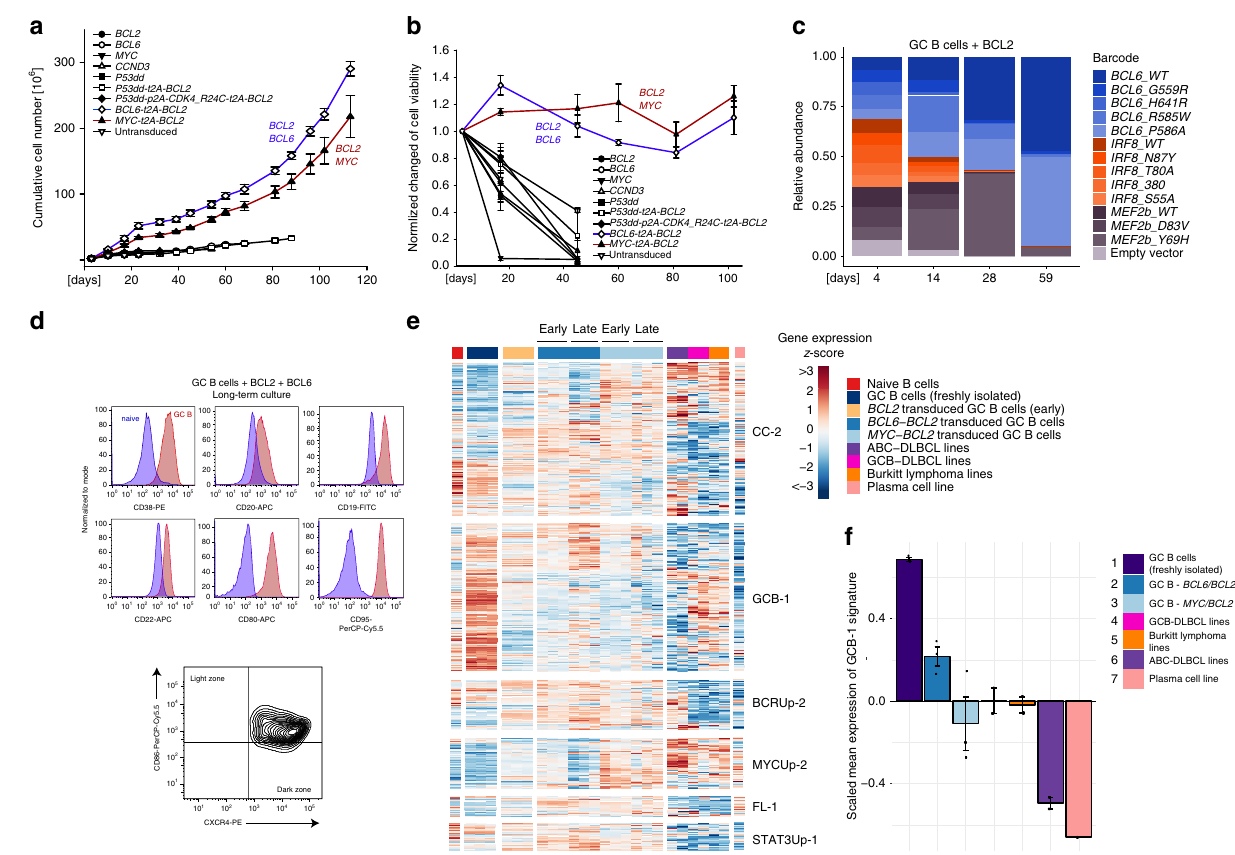
Fig. 2 Long-term expansion of human germinal center B cells ex vivo. a Primary human GC B cells were transduced with the indicated oncogenes and oncogene combinations and cultured separately for up to 120 days. Graph shows calculated theoretical absolute cell numbers (±s.e.m., n = 3). Viable cells were assessed by trypan blue exclusion. Source data are provided as a Source Data fi le. b Primary human GC B cells were transduced with different oncogenes and oncogene combinations and monitored by fl ow cytometry. Graph shows the change in cell viability assessed by scatter characteristic by fl ow cytometry ( ± s.e.m., n = 3). Source data are provided as a Source Data fi le. c Primary human GC B cells were transduced with BCL2 in combination with other transcription factors in a pooled, competitive culture. Graph shows relative abundance of transcription factors or their mutant versions over four different timepoints ( n = 3). d Primary human GC B cells were transduced with the oncogenic cocktail BCL2 and BCL6 and cultured to day 73. Representative fl ow cytometry analysis ( n = 3) for the expression of the GC B cell markers CD38, CD20, CD19, CD80, CD22, CD95, CXCR4, and CD86. Red histograms show GC B cells compared to primary human naïve B cells (blue). e Heat map of gene expression of freshly isolated GC B cells ( n = 3), transduced GC B cells ( BCL2-BCL6, BCL2-MYC ) cultured ex vivo for 5 or 73 days ( n = 3), plasma cell line ( n = 1), naïve B cells ( n = 1), and lymphoma cell lines (TMD8, HBL1, SUDHL4, DOHH2, Mutu, and Raji, n = 6). Illustrated are the selected gene expression signatures — CC-2, GCB-1 as well as BCRUp-2, MYCUp-2, FL-1, and STAT3Up-1 (Supplementary Table 1). Order of genes in the signatures was determined by hierarchical clustering. f Bar chart showing the scaled mean expression of the germinal center B cell signature, GCB-1 in freshly isolated GC B cells ( n = 3), transduced GC B cells ( BCL2-BCL6, BCL2- MYC bars represent the standard error of the mean from independent biological